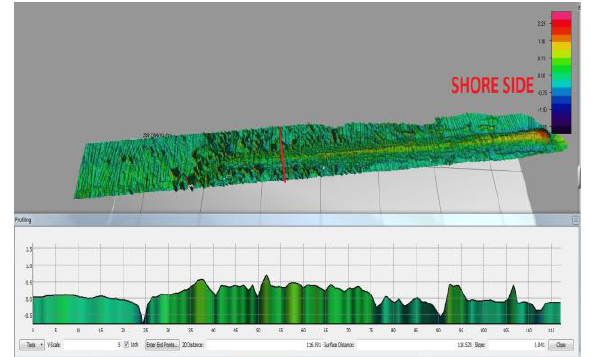
Figure 17: Change detection profile of the deeper part of the